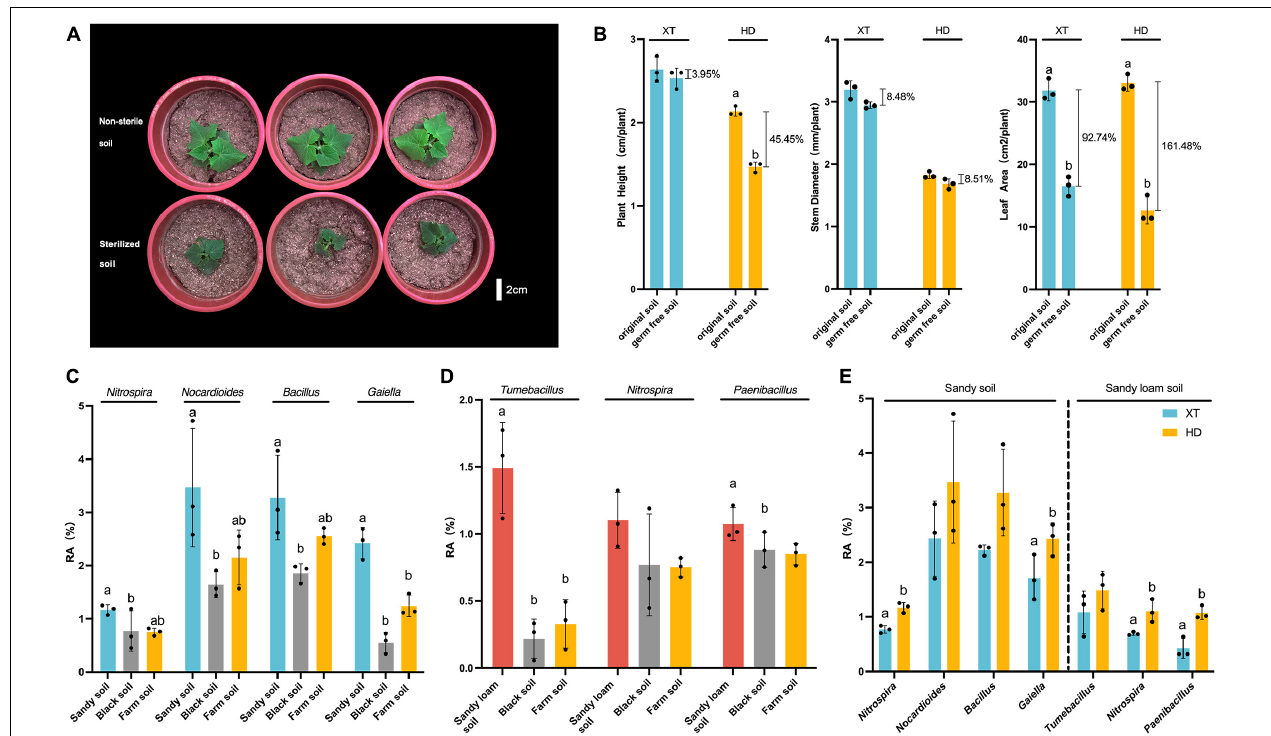
FIGURE 4 | The dominant bacteria in HD rhizosphere of sandy soil and sandy loam soil. (A) HD planted in non-sterile soil and sterilized soil of sandy loam soil at 40 DPS. (B) Plant height, stem diameter and leaf area of XT and HD in non-sterile soil and sterilized soil of sandy loam soil at 40 DPS. (C) Relative abundances of Nitrospira , Nocardioides , Bacillus and Gaiella in three kinds of soils at 50 DPS. (D) Relative abundances of Tumebacillus , Nitrospira , and Paenibacillus in three kinds of soils at 50 DPS. (E) Relative abundances of Nitrospira , Nocardioides , Bacillus and Gaiella of XT and HD rhizosphere in sandy soil; relative abundances of Tumebacillus , Nitrospira , and Paenibacillus of XT and HD rhizosphere in sandy loam soil. Data are the means of three replicates, and error bars indicate standard deviations ( p < 0.05); significance among different groups is indicated by Student’s t -test. Letters represent the results of Student’s t